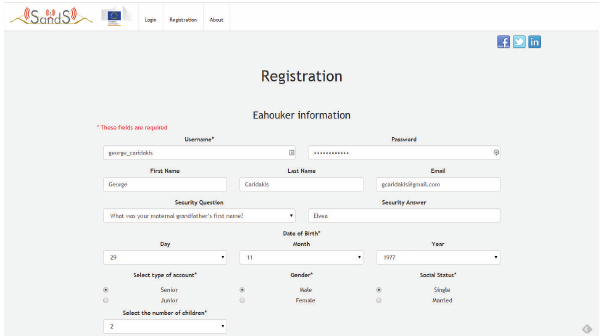
Figure 4: SandS user registration